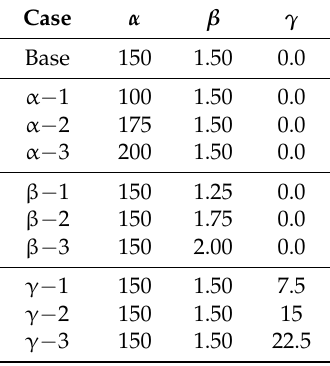
Table 2. Sensitivity matrix for weighting